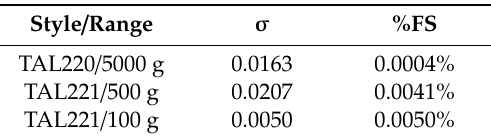
Table 3. The average standard deviation for each load cell during repeatability testing is compared as a percentage of the load cell’s total range. These results suggest that the precision of the load cell is a function of its range and style.